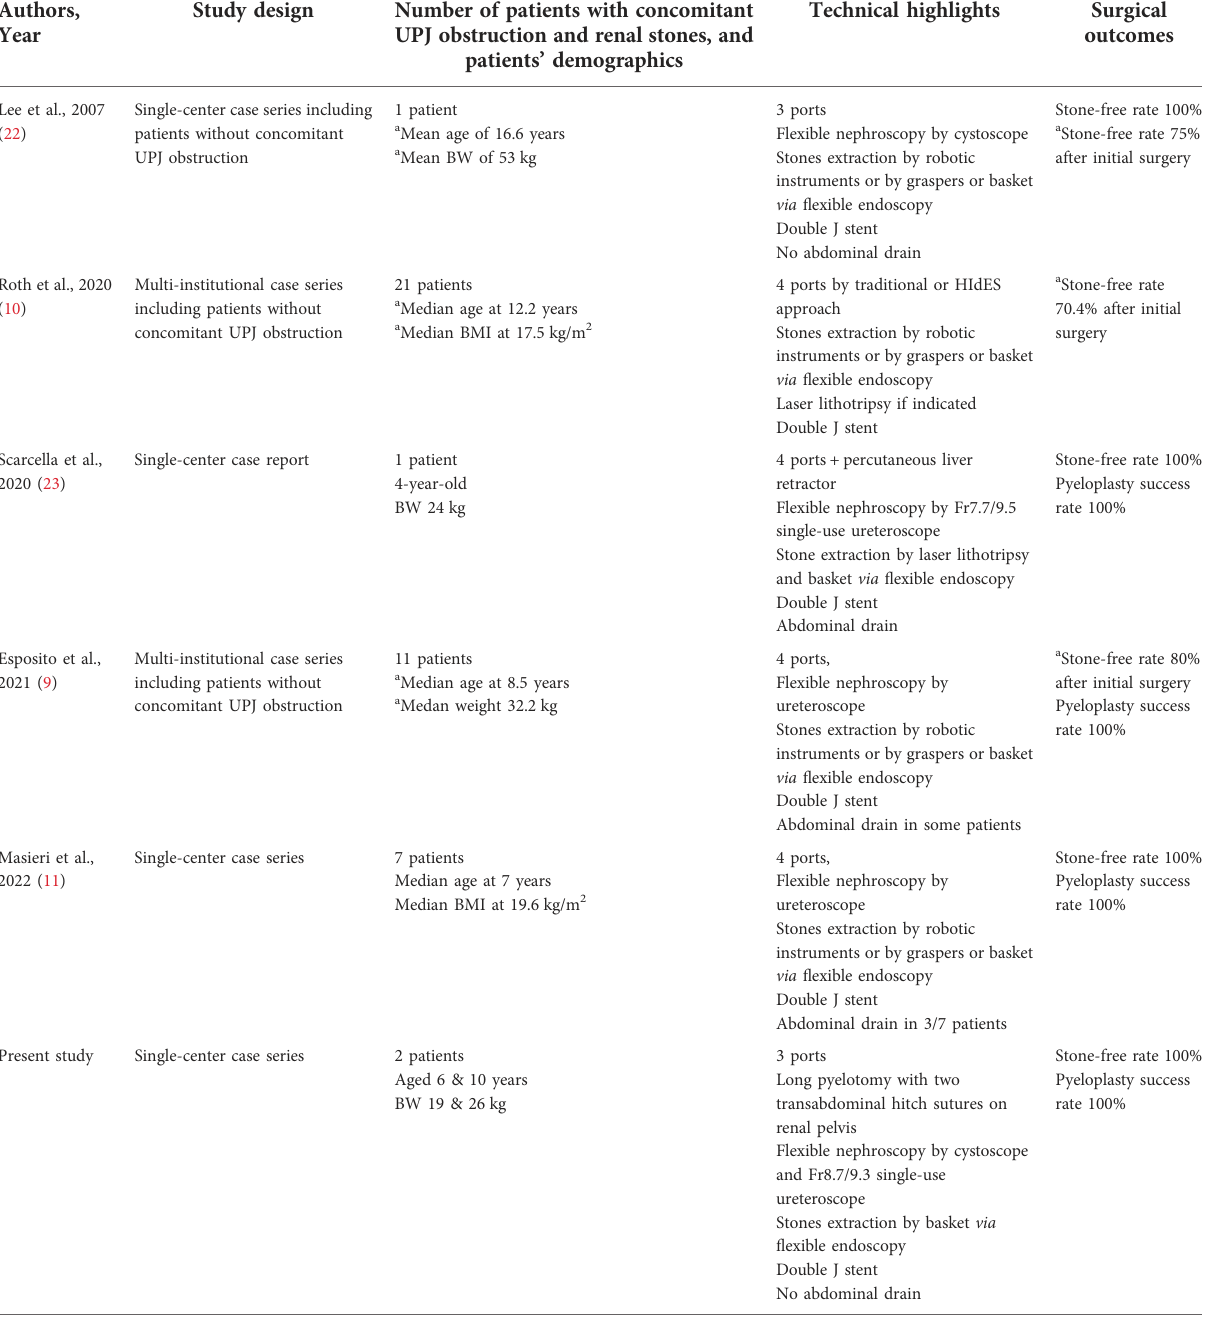
TABLE 1 Summary of pediatric literature reporting on the combined approach of RALP and fl exible endoscopy to treat concomitant UPJ obstruction and renal stones.